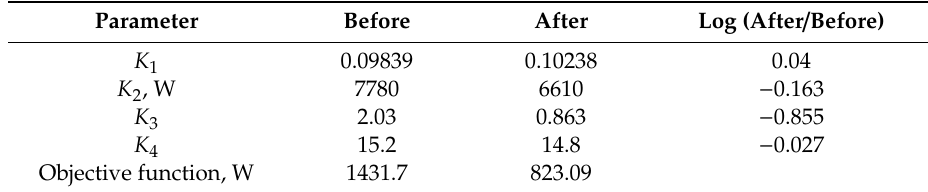
Table 4. Optimization